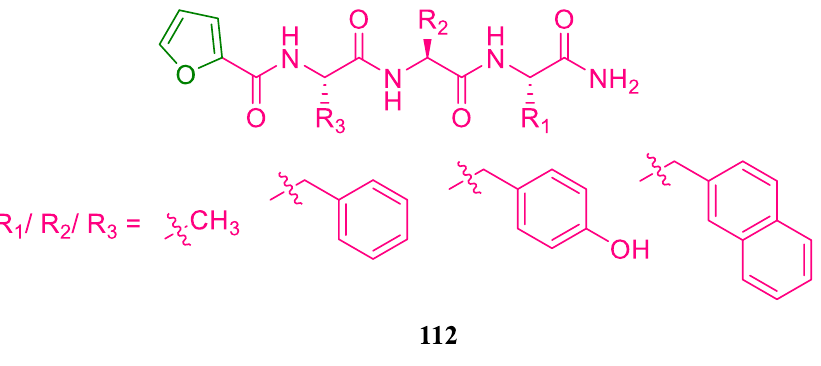
Figure 91. Furan-conjugated